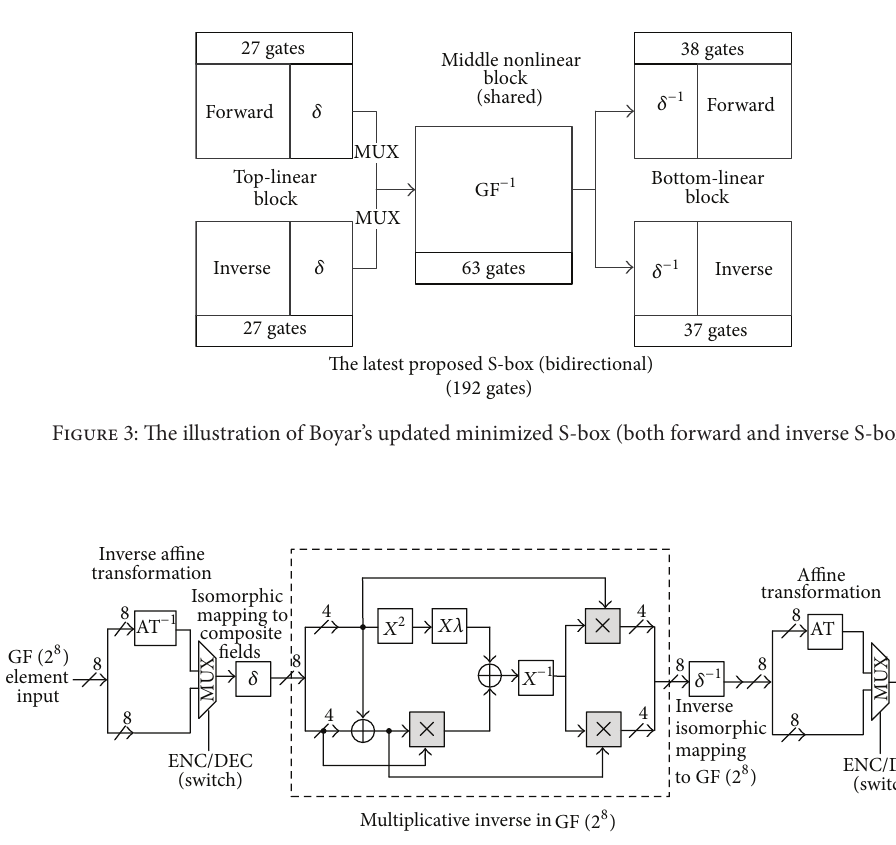
Figure 4: The illustration of the composite field S-box